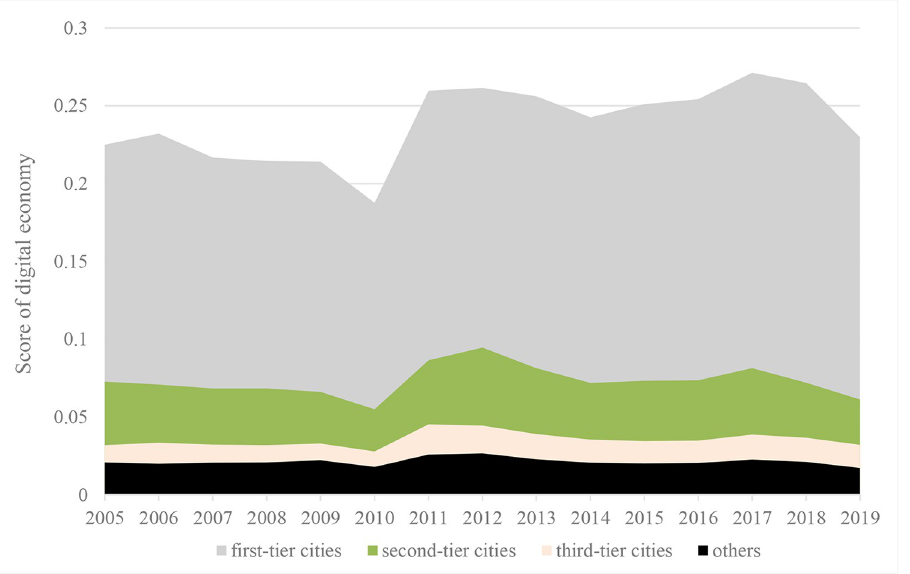
Fig 5. Digital economy development level at different development of the city economy.